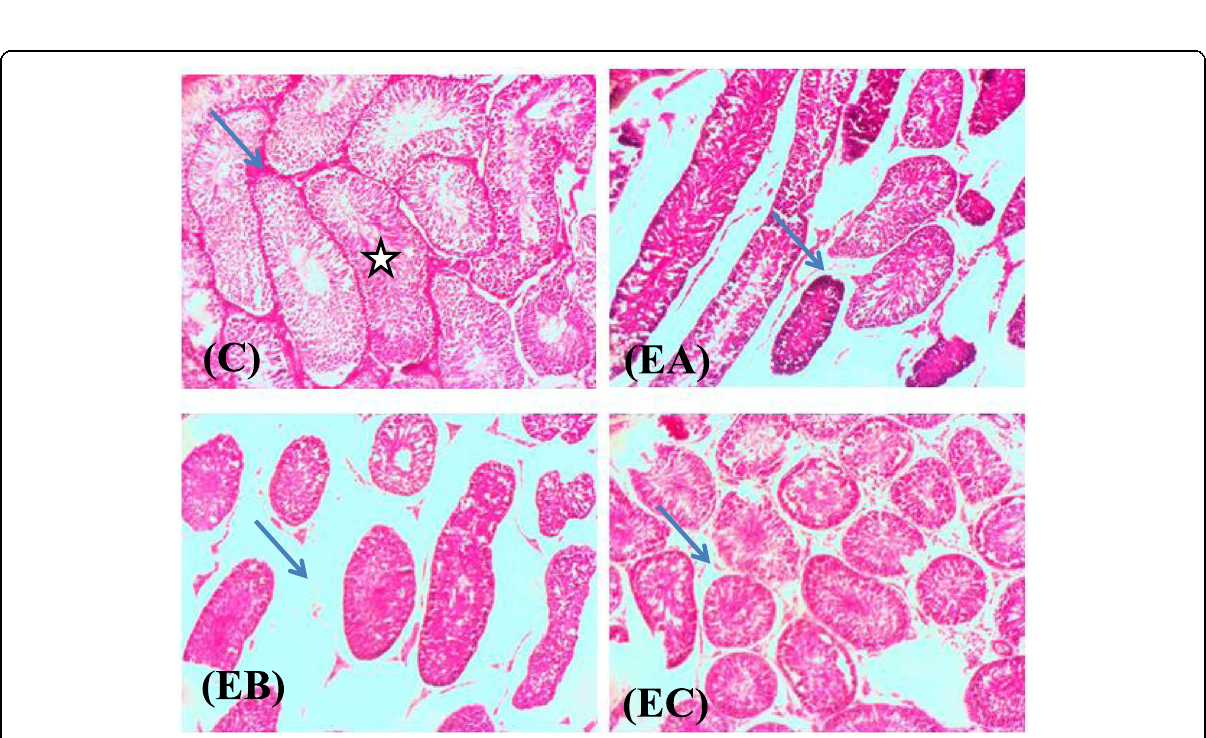
Fig. 2 Photomicrographs of the testis of male Wistar rats exposed to different doses of ethyl acetate soluble fraction of WILR. Control (C): normal testis showing the seminiferous tubules (star) and interstitium (blue arrow). 200 μ g/kg (EA): loss of interstitium (blue arrow) and germ cells. 500 μ g/kg (EB): loss of interstitium (blue arrow) and germ cells. 1000 μ g/kg (EC): loss of interstitium (blue arrow) and erosion of germinal epithelium. H&E ×